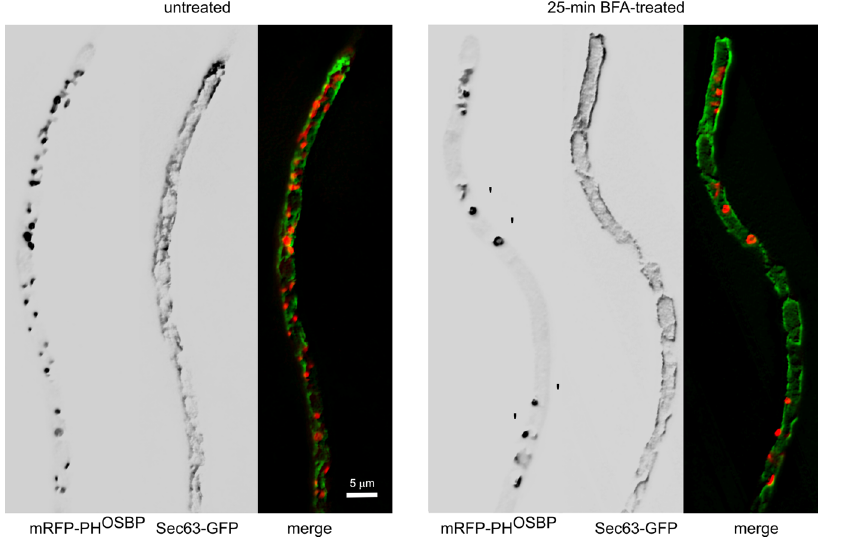
Figure 7. The ER is brefeldin A-insensitive. A strain coexpressing Sec63-GFP with the late Golgi marker mRFP-PH OSBP was treated with brefeldin A for 25 min. Under these conditions, late Golgi cisternae form aggregates. In contrast, the ER appears to be largely resistant to the drug. Images represent maximal intensity projections of z-stacks of deconvolved images.